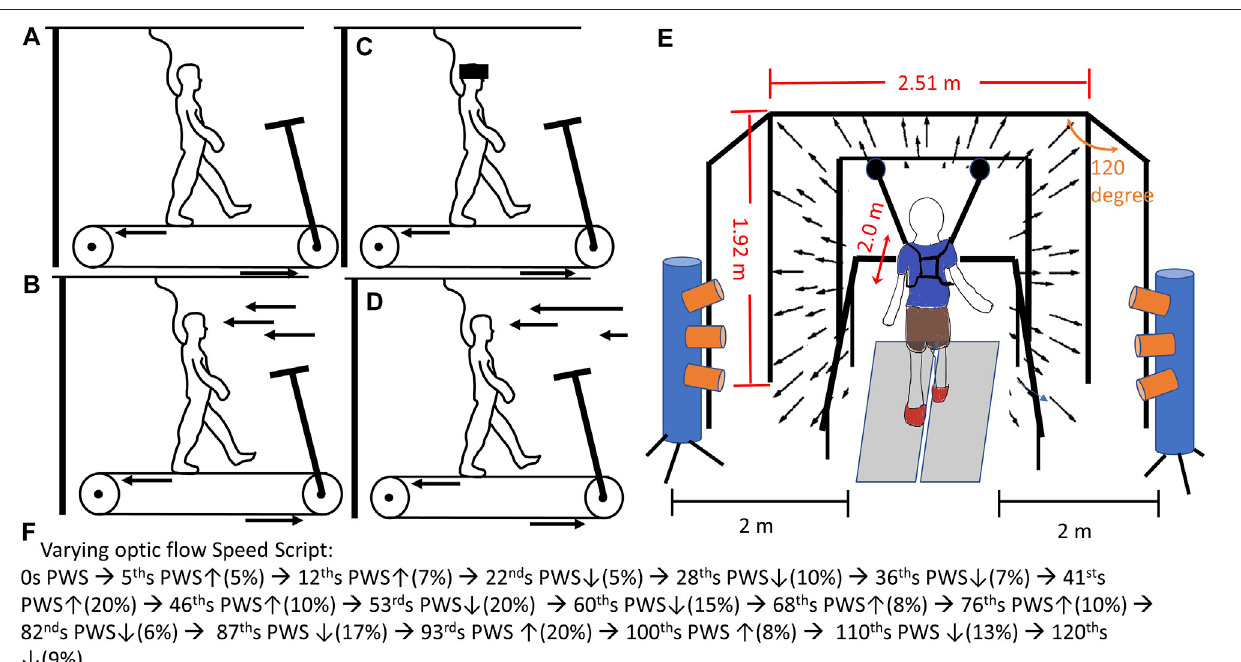
FIGURE1| Theexperimental diagram: (A) walkingonthetreadmillwithoutoptic fl ow(noOptic),35; (B) walkingonthetreadmillwiththeoptic fl owandthespeedof optic fl owwasmatchedtotreadmill speed(Optic); (C) walkingonthetreadmill withgoggle,whichreducedthevisualcapabilitiesforparticipants (Vre); (D) walkingonthe treadmill under pseudo-random visual perturbations (Vpe). This pseudo-random was made by the script: ↑ represented speed up % of preferred walking speed, and ↓ representedspeeddown%ofpreferredwalkingspeed. (E) Thisvirtualrealityprovidedanoptic fl owspeedmatched/mismatchedtoparticipants ’ preferredwalking speed coding by Python using the WorldViz LLC graphics library (Santa Barbara, CA, United States). The optic fl ow was projected by three commercial projection systems(OptomaTX774,OptomaTechnologyInc., Milpitas, CA).Eachscreenwasof2.51 mwidthand1.72 mheight.Thefrontscreenwasplaced2 mawayfromthe treadmill. The side screen placed 120 ° against the front screen. The two motion capture cylinders with three lenses for each cylinder (Optotrak Certus, Northern Digital Inc., Waterloo, Canada) were placed 2 m away from the treadmill on the side. This optimal range was set based on the Optotrak Certus User Guide (https://tsgdoc. socsci.ru.nl/images/e/eb/Optotrak_Certus_User_Guide_rev_6%28IL-1070106%29.pdf)for accurately capturing the infrared lightemitting diode markers placed onhip (greater trochanter),knee (lateralepicondyle), ankle (lateral malleolus), toe (2nd Metatarsal), and heelof each foot. The accuracy ofthis motion capture system was upto 0.1 mm and resolution 0.01 mm. This motion capture system was validated by Schmidt et al. ’ s study (Greenlee,